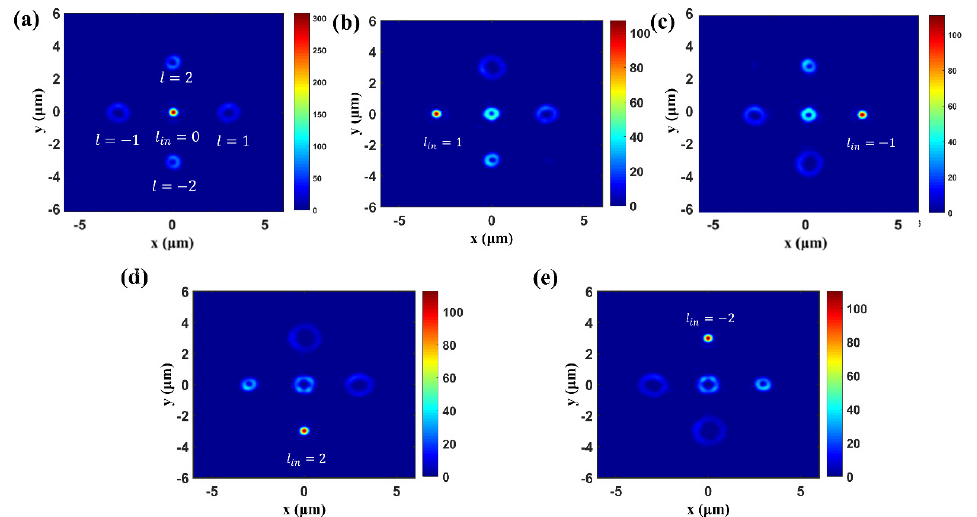
Figure 6. Numerical simulated result of a multichannel FOV generator operating in transmission mode. ( a ) The RCP incident wave illuminates the generator along the positive z -axis and divides into five FOV beams with different orbital angular momentum (OAM) values. ( b – e) The incident waves with di ff erent topological charge numbers of ( b ) l = 1, ( c ) l = − 1, ( d ) l = 2, and ( e ) l = − 2 illuminate the generator. ( b – e ) The corresponding intensity profiles on the focal plane at 𝑧 = 10 μm .